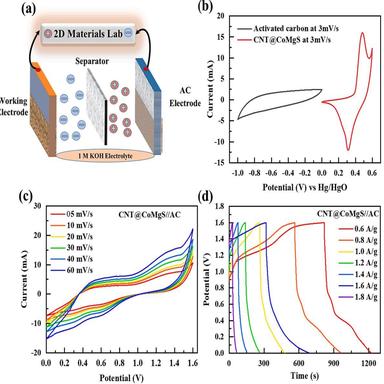
(a) Schematic illustration of the supercapattery association, (b) comparison of CV curves (c) CV measurements in two-electrode assembly. (d) GCD curves in two-electrode assembly using a real device at PW (0 to 1.6 V) with altered current densities (0.6–1.8 A/g).